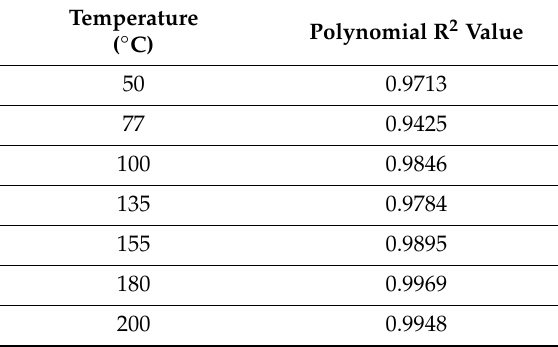
Figure 8. Thermocouple-interfaced sensor response. Table 3. Curve fitting accuracy of resonant response.